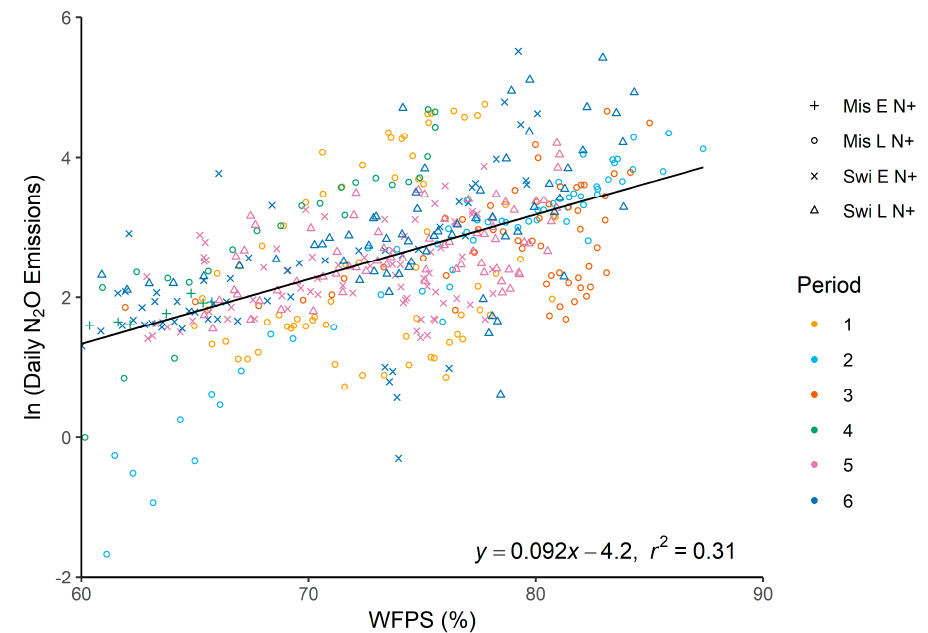
Figure 8. Relationship between daily N 2 O emissions (log transformed) and WFPS (0–30 cm) for fertilized perennial crops during the 70 days following N fertilization and for WFPS ≥ 60%. Colors are periods of measurement. The continuous line is the common linear regression. See Table 1 for treatment abbreviations.